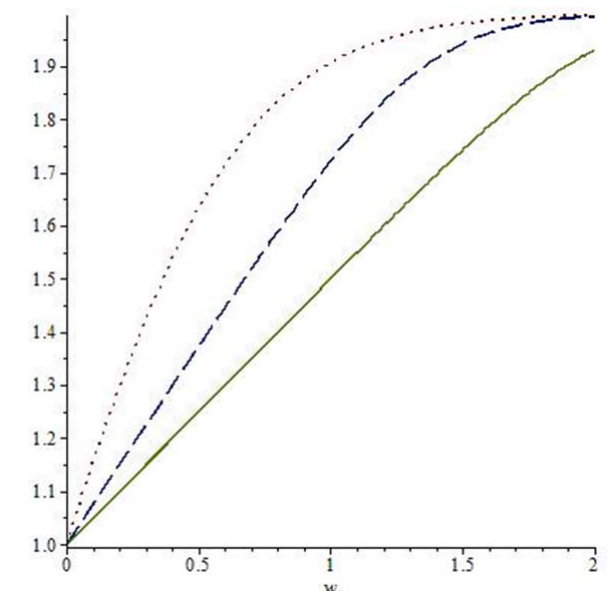
Figure 1. Function (cid:1834)(cid:4666)(cid:1875)(cid:4667) when (cid:1858) ≡ (cid:3398)1 and (from left to right) ϵ = 0.5, 0.25 and